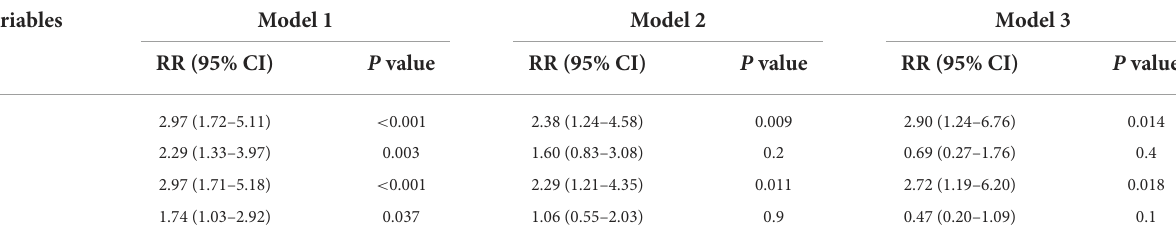
TABLE 3 Odds ratios and 95% CIs for the association between hippocampal subfields and insomnia using logistic regression analysis.